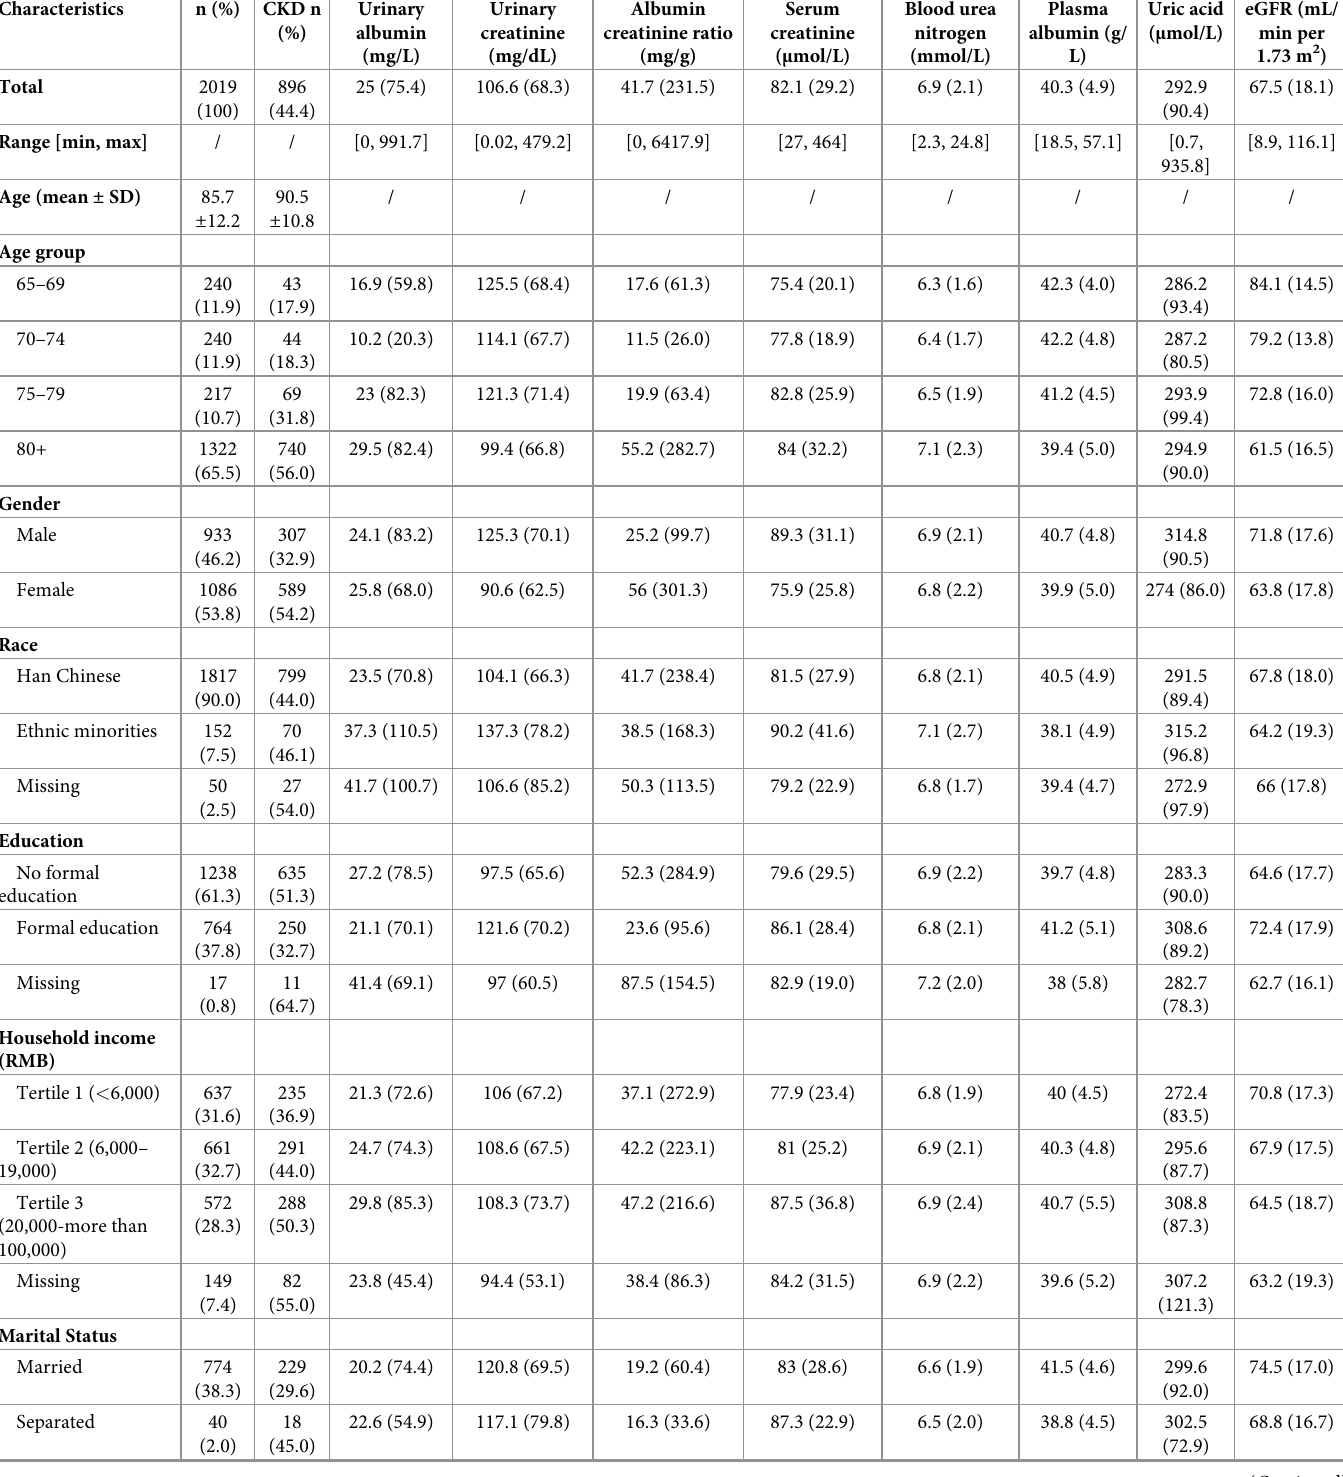
Table 1. Demographic characteristics and mean (SD) of biomarkers (Chinese participants: CLHLS 2012).